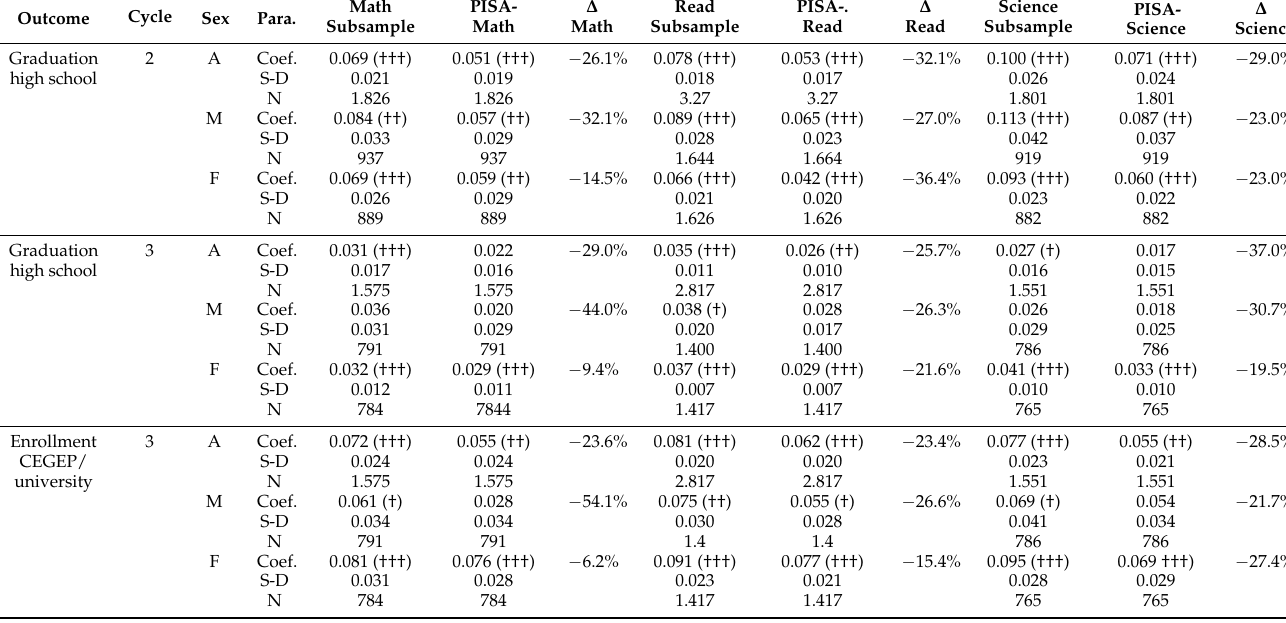
Table 6. Estimated effects of independent high school on academic outcomes by sex and PISA scores as additional matching covariate, cohort A cycles